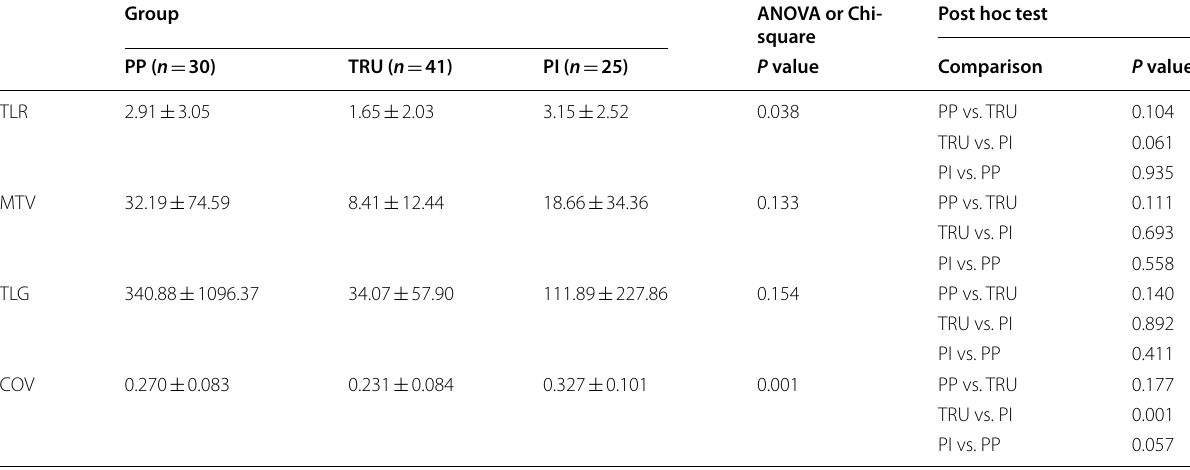
Table 3 Correlation between molecular subtypes and 18 F‑FDG